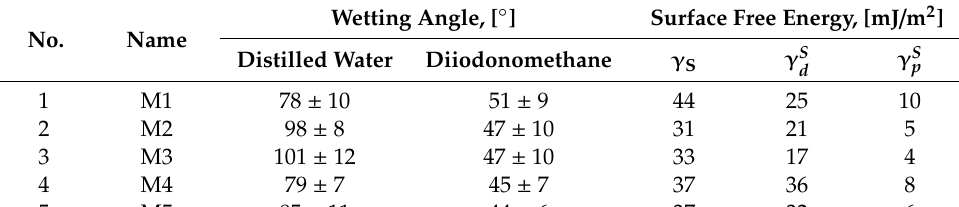
Table 7. Results of contact angle measurements and SFE calculated.